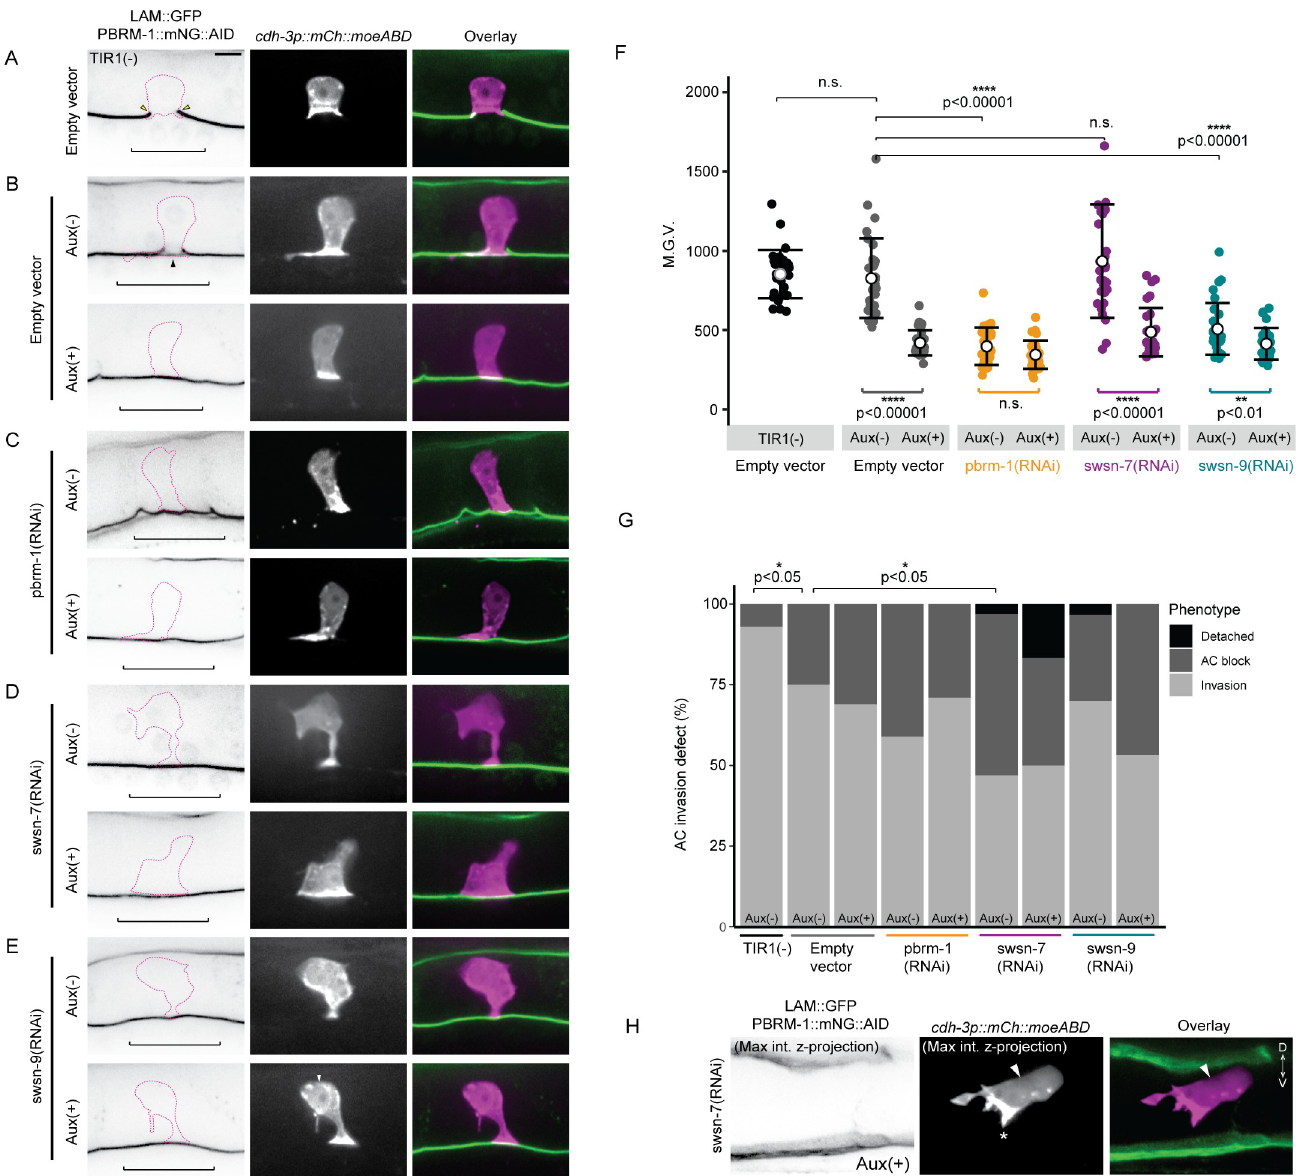
Fig 8. PBAF promotes AC contact to the BM. Representative micrographs of BM ( lam :: GFP ) and endogenous pbrm-1 :: mNG :: AID (left), AC ( cdh-3p :: mCherry :: moeABD , center), and fluorescent overlays (right) of animals lacking (A) or possessing (B-E) ubiquitous TIR1 expression treated with empty vector control (B) or RNAi targeting PBAF subunits in the absence Aux(-) (top) or presence Aux(+) (bottom) (C-E). PBRM-1::mNG::AID images have been inverted for ease of visualization. Magenta dotted lines delineate boundaries of ACs. Scale bar, 5 μ m. (F) Quantification of fluorescence expression (M.G.V) of PBRM-1::mNG::AID in ACs of animals in each condition (N � 30 animals in each treatment; p values for Fisher’s exact test comparing strains containing TIR1 to the TIR1(-) strain, and comparing strains containing TIR1 in the Aux(-) to the Aux(+) condition, are displayed above compared groups). (G) Stacked bar chart showing percentage of AC invasion defects corresponding to each treatment, binned by AC phenotype (N � 30 animals per condition; Fisher’s exact test determined significance for penetrance of AC invasion defects between indicated conditions; all groups were compared and only significant comparisons were displayed). Black brackets indicate statistical significance between total invasion defect in each condition. (H) Max intensity z-projection of AC and BM reporter channels depicting a detached AC phenotype in swsn-7 -deficient AC in the Aux(+) condition. BM (left), AC (center), fluorescence overlay (right). Asterisk in middle panel indicates polarized F-actin driven protrusion extending